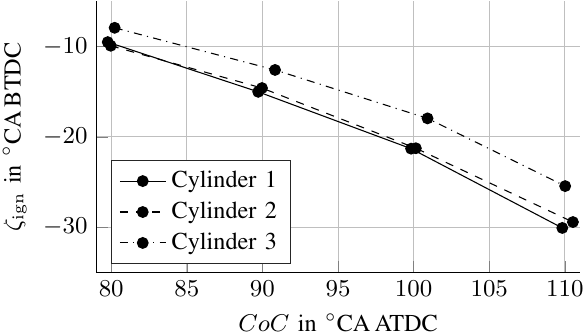
Figure 4. Correlation between center of combustion ( CoC ) and ignition angle ( ζ ign ) in all three cylinders.